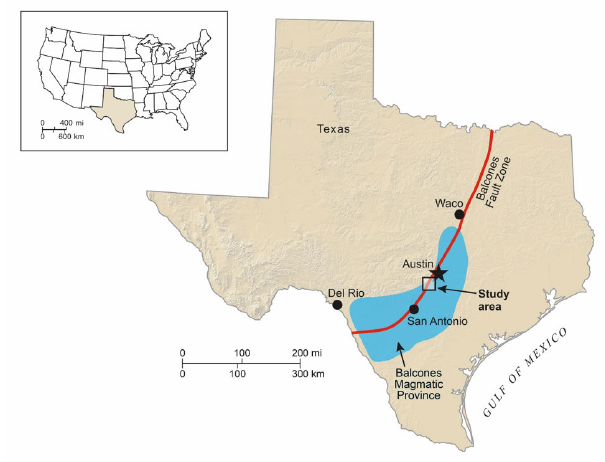
Figure 1: Maps showing the Balcones Magmatic Pro- vince and the Balcones Fault Zone, and the study area (modified after Saribudak [2016]). The Balcones Mag- matic Province is defined by the surface extent of Cre- taceous igneous